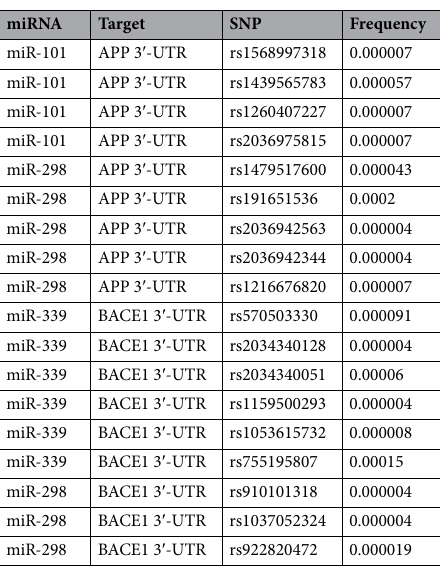
Table 1. SNPs located within or close to miRNA seed sequence binding sites* *SNP information was obtained from dbSNP of National Center for Biotechnology Information. https:// www. ncbi. nlm. nih. gov/ snp/ rs156 89973 18? verti cal_ tab=